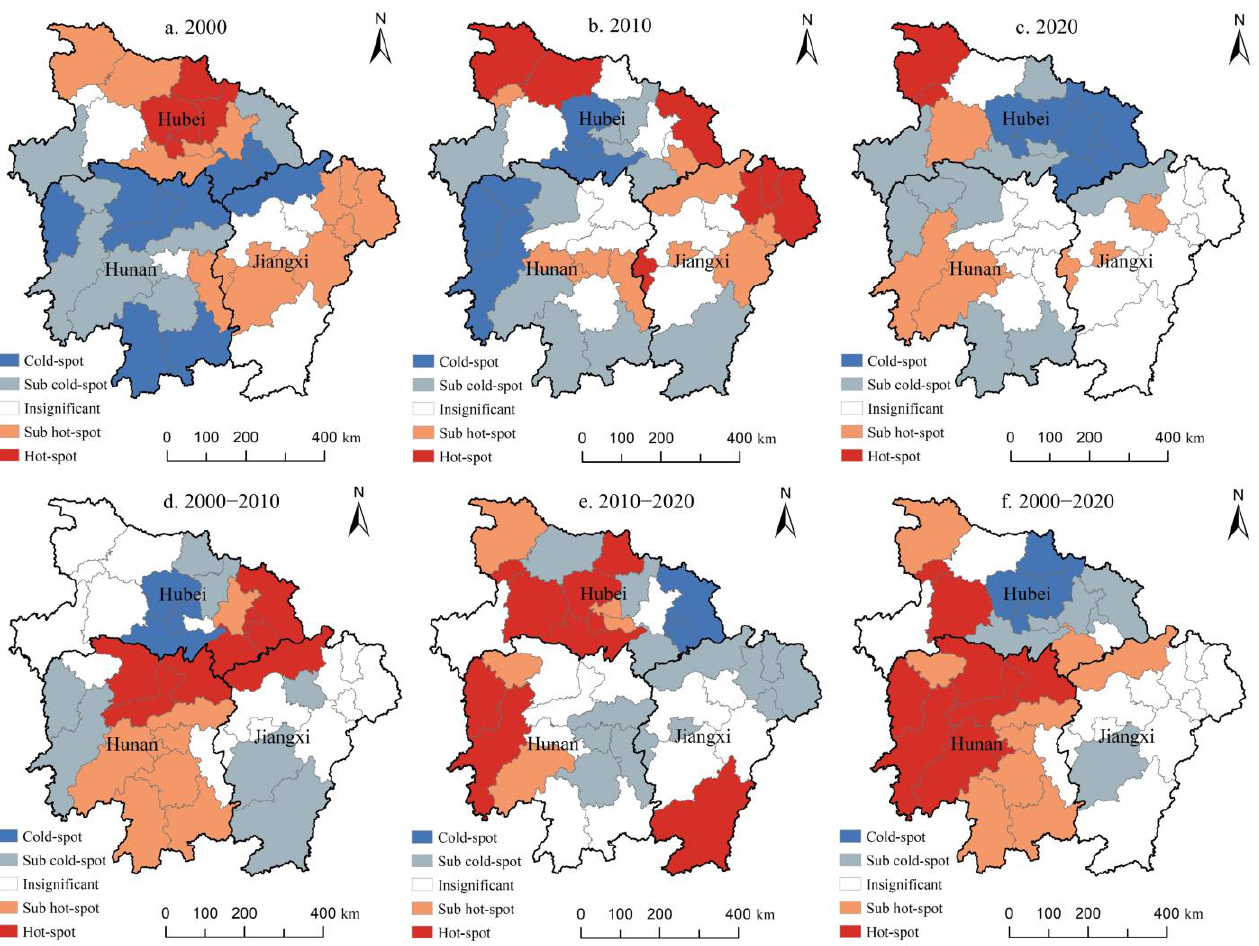
Figure 5. The cold-spot and hot-spot distribution characteristics in the current situation and change dynamics of CLUE in the MRYR. ( a – c ) Cold-spot and hot-spot areas of the current situation of CLUE in 42 cities in the MRYR in 2000, 2010, and 2020, respectively. ( d – f ) Cold-spot and hot-spot areas of CLUE change dynamics in 42 cities in the MRYR during 2000−2010, 2010−2020, and 2000−2020, respectively.